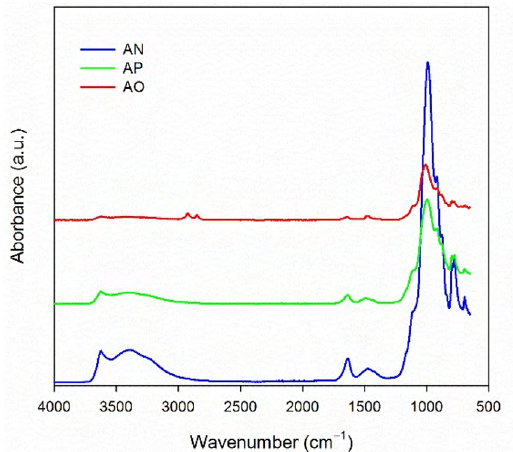
Figure 1. FTIR spectra of natural (AN), purified (AP) and purified/ organophillized (AO) Bentonite clays.